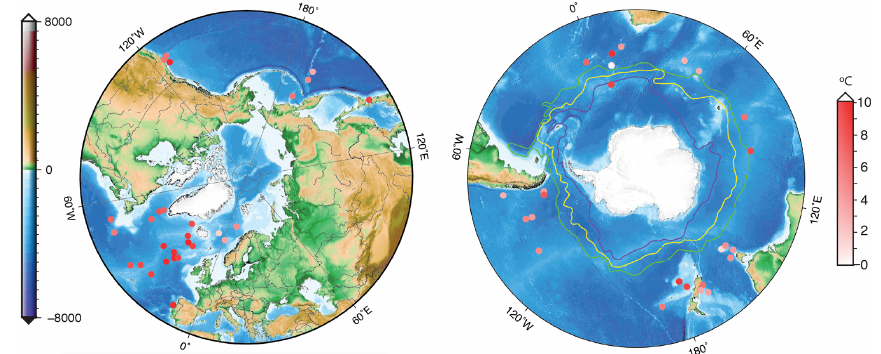
Figure 7. Mid- to high-latitude sea surface temperature (SST) differences between SSTs in late Marine Isotope Stage 6 and maximum SSTs of the early Last Interglacial (Stage 5). Map made using Generic Mapping Tools (GMT) (Wessel et al.,